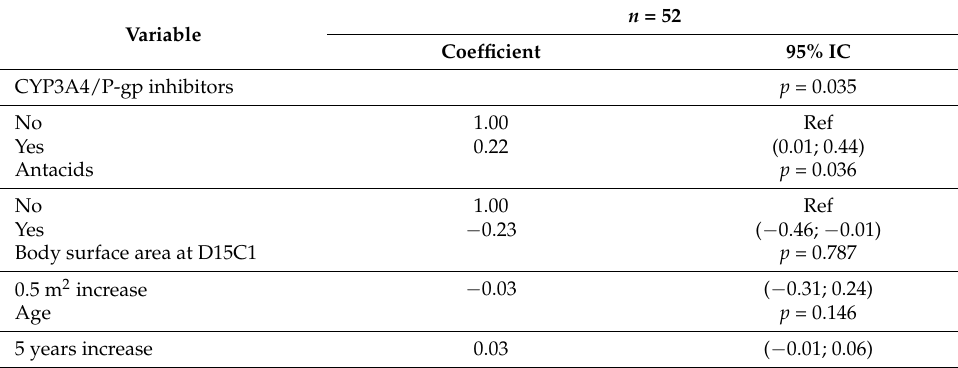
Table 4. Adjusted association between comedications at D15C1 and log-concentration at D15C. Multivariate linear regression ( n =